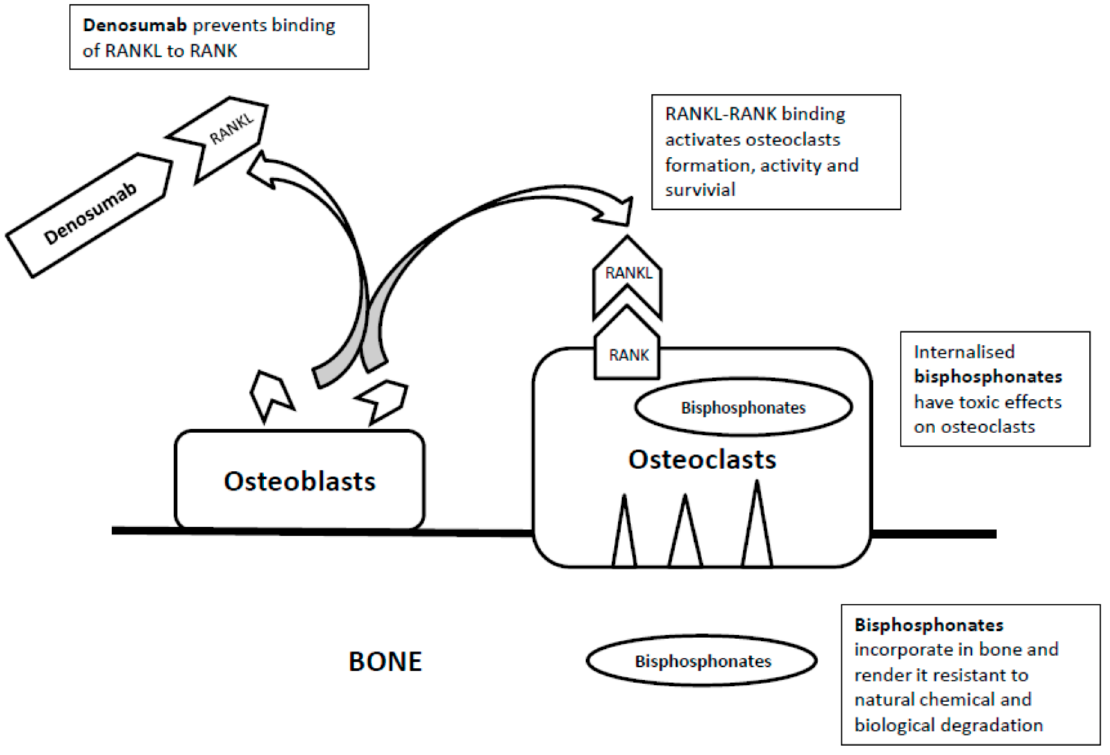
Figure 1. The mechanisms of action of bisphosphonates and denosumab.